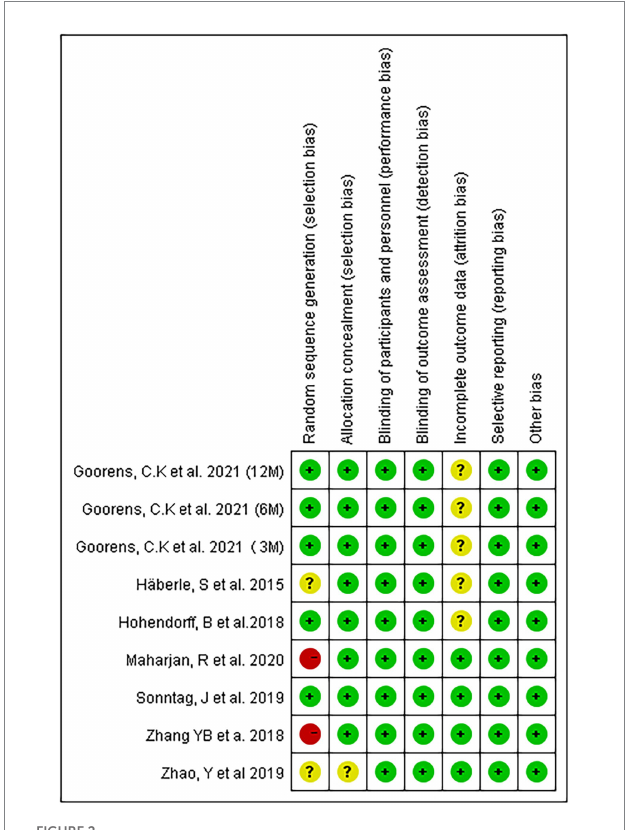
FIGURE 2 Risk of bias summary: review authors’ judgments about each risk of bias item for each included study.